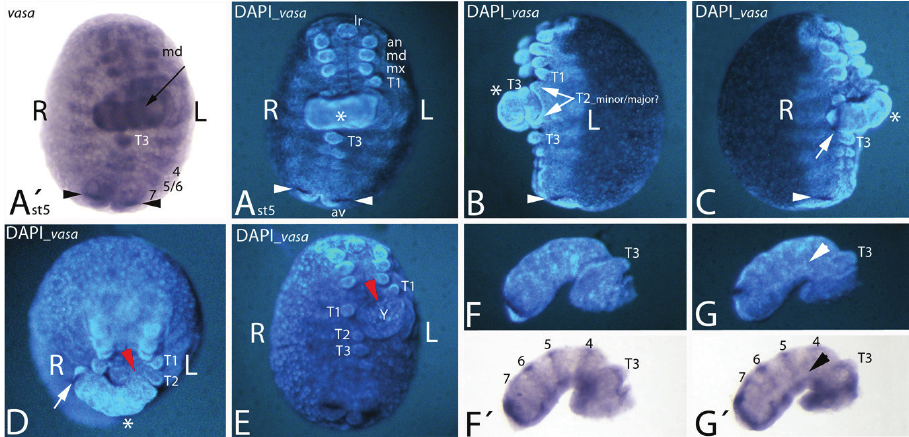
Figure 1. An unusual abnormally developed embryo of the type Duplicitas posterior . A´–e Whole- mount embryo. Anterior is towards the top. F–G´ Separated minor germ band. Posterior is to the left. A´ shows the bright-field photography of the embryo stained for vasa . Ventral view. Arrow points to stripe of expression in the minor germ band. A DAPI corresponding to A´. The asterisk marks the minor germ band. Arrowheads point to strong expression of vasa near the rear end. B Lateral view on left side. Asterisk and arrowhead as in A . Arrows point to T2 appendages. C Lateral view on right side. Asterisk and arrow- head as in A . Arrow points to strong expression of vasa in the minor germ band. D Ventral view. Embryo tilted towards beholder. Asterisk and arrow as in C . Red arrowhead points to contact point of minor germ band with major germ band. e Ventral view. Minor germ band was surgically removed. Red arrowhead as in D . F/G Separated minor germ band. Lateral views at different angles. F´/G´ Bright-field photographs corresponding to F/G . Arrowhead in G/G´ points to lack of dorsal vasa expression. Abbreviations: 4 to 7 vasa expression in the dorsal segmental units four to seven; 5/6 vasa expression in the fused dorsal tissue (diplosegment) aligned with T5 and T6; an antenna; L left side of embryo; md mandible; mx maxilla; R right side of embryo; T1-T2 first to third walking limb; Y